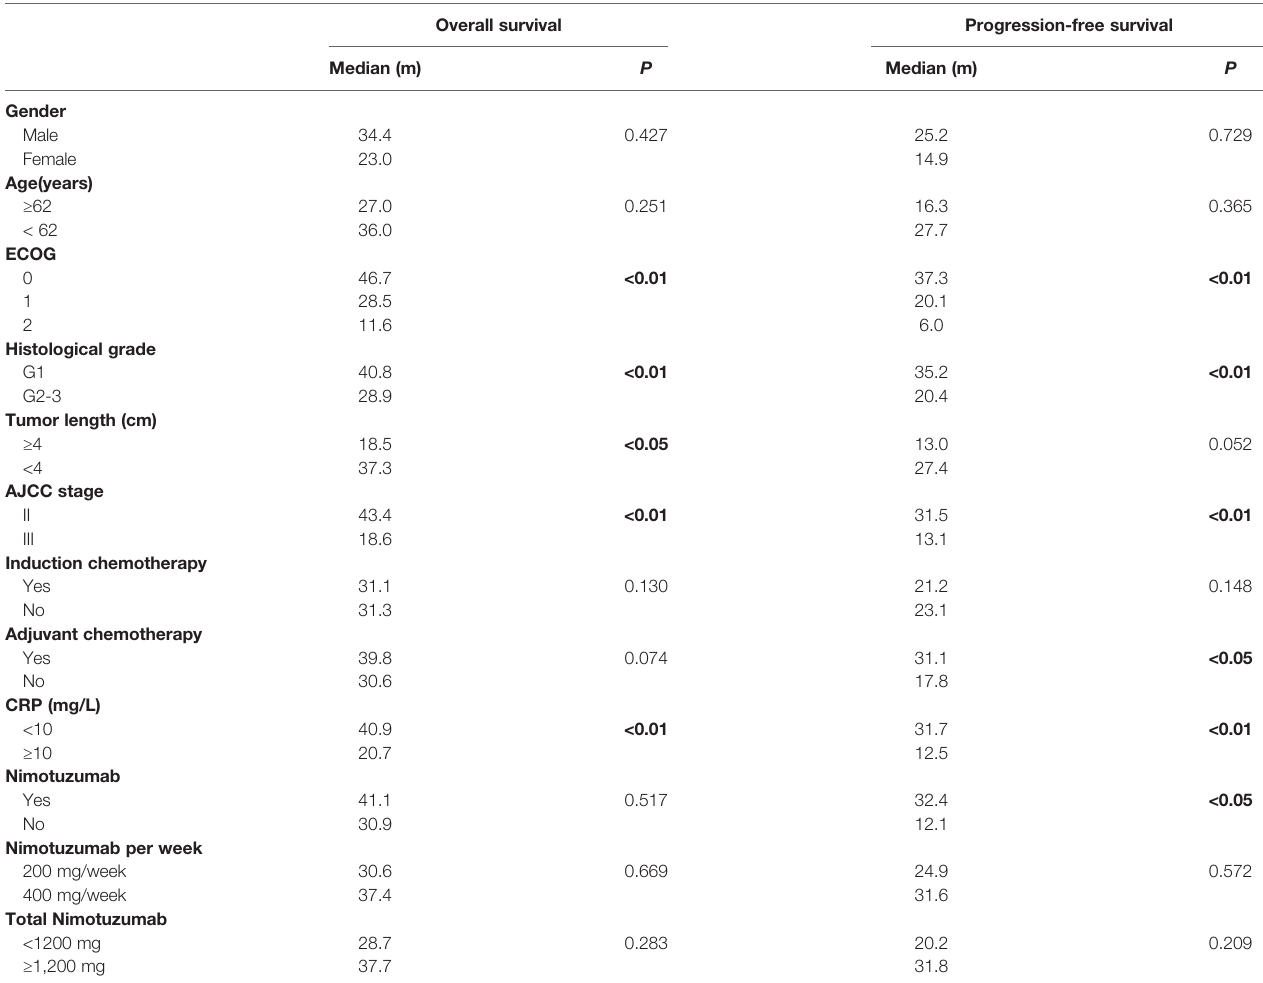
TABLE 4 | Univariate analyses of clinical parameters of OS and PFS in overall patients.